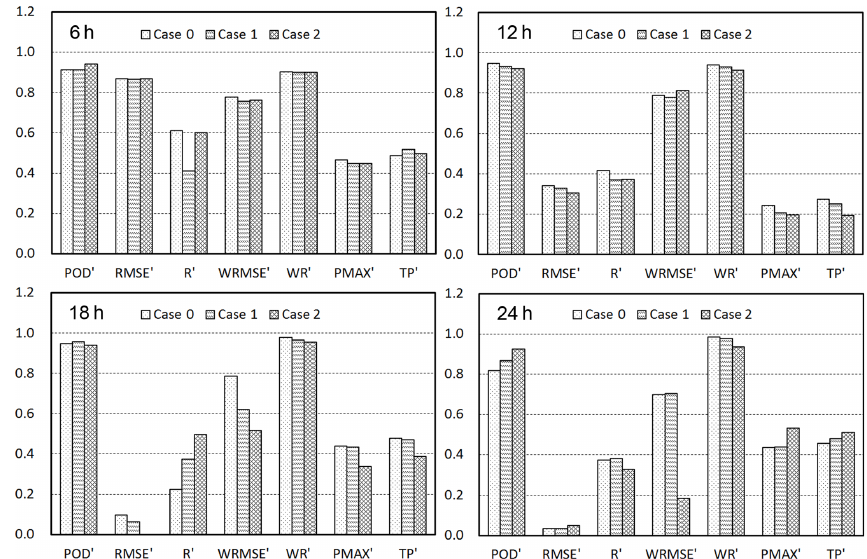
Figure 3. Spatial values of the verification metrics for the WRF domain size experiments, calculated over different temporal durations and over domain three. Case 0 (C0) incorporates the smallest domain, which covers north-central China; Case 1 (C1) incorporates a domain of intermediate size that covers northern China and part of Mongolia; and Case 2 (C2) incorporates the largest domain, which covers the Northern Hemisphere. The metrics are calculated over time periods of 6, 12, 18, and 24h that begin at 12:00UTC on 21 July